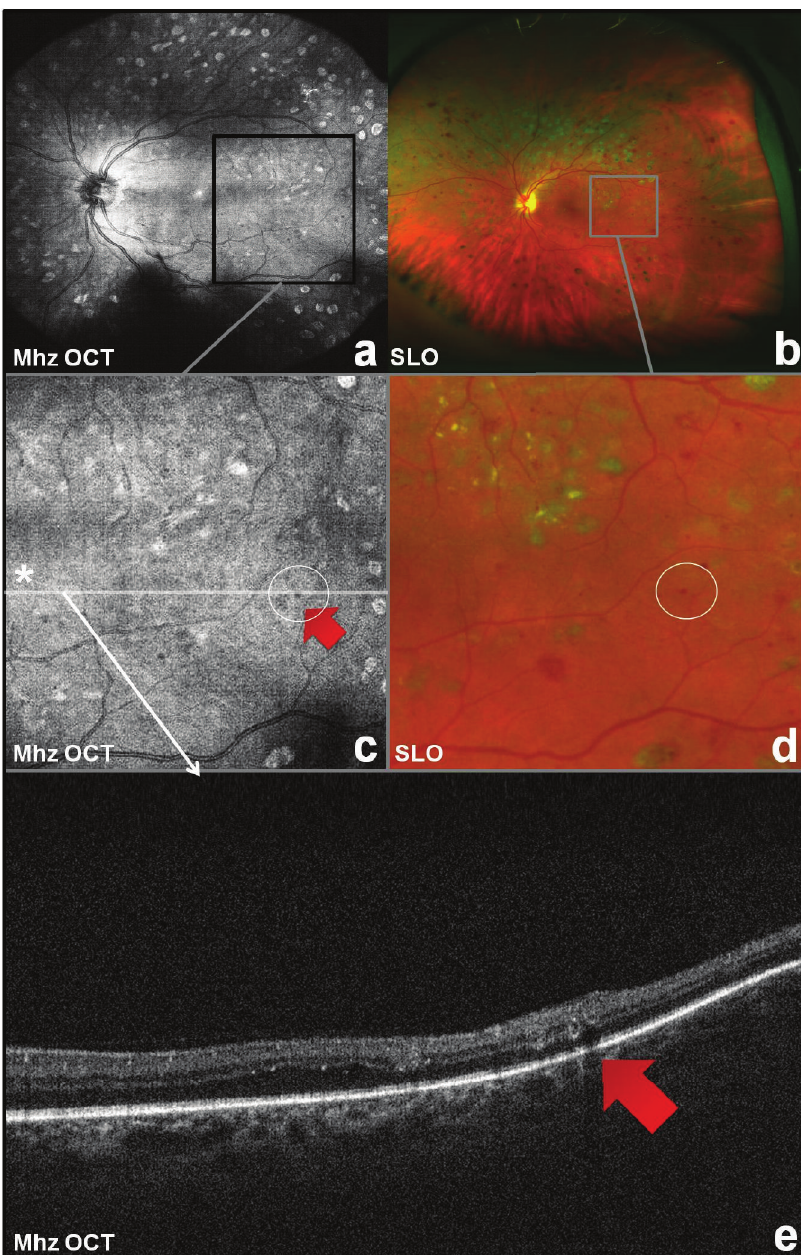
Figure 4: Reconstructed MHz OCT en face wide-field fundus image of left eye (a) with detail (c) versus wide-field scanning laser ophthalmoscopy (SLO) image (b) with detail (d). Cross-sectional MHz OCT scan from the same dataset (a, c) through a microaneurysm (red arrow) providing information in 𝑧 -axis